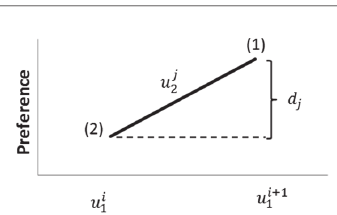
Fig. 3. Preference difference created by changing criterion 1 from one of its levels to